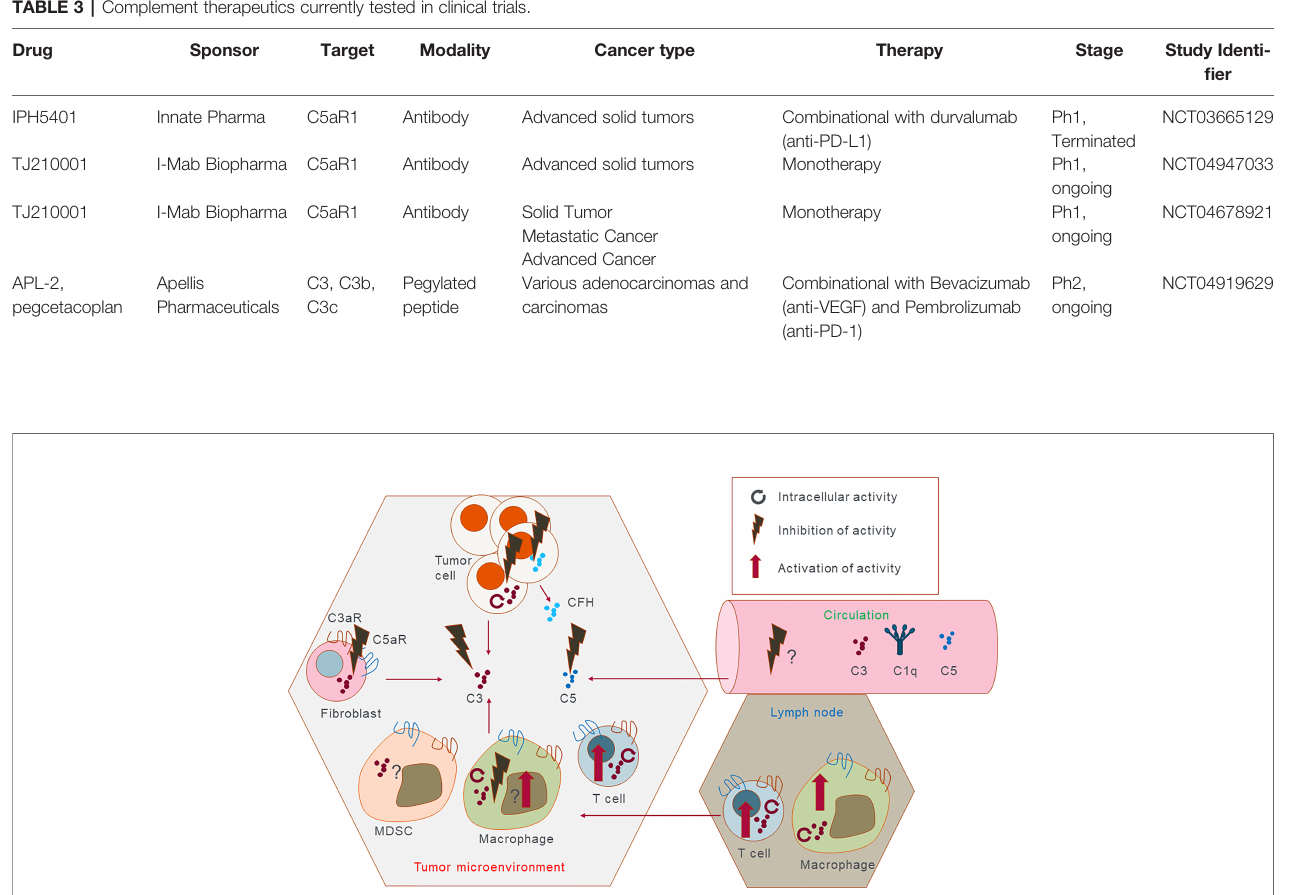
TABLE 3 | Complement therapeutics currently tested in clinical trials.